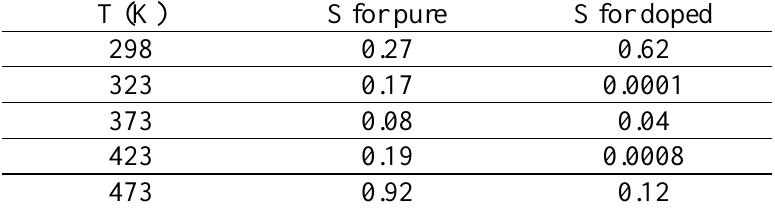
Table 1: Values of frequency exponent for pure ZnS and ZnS:Pb